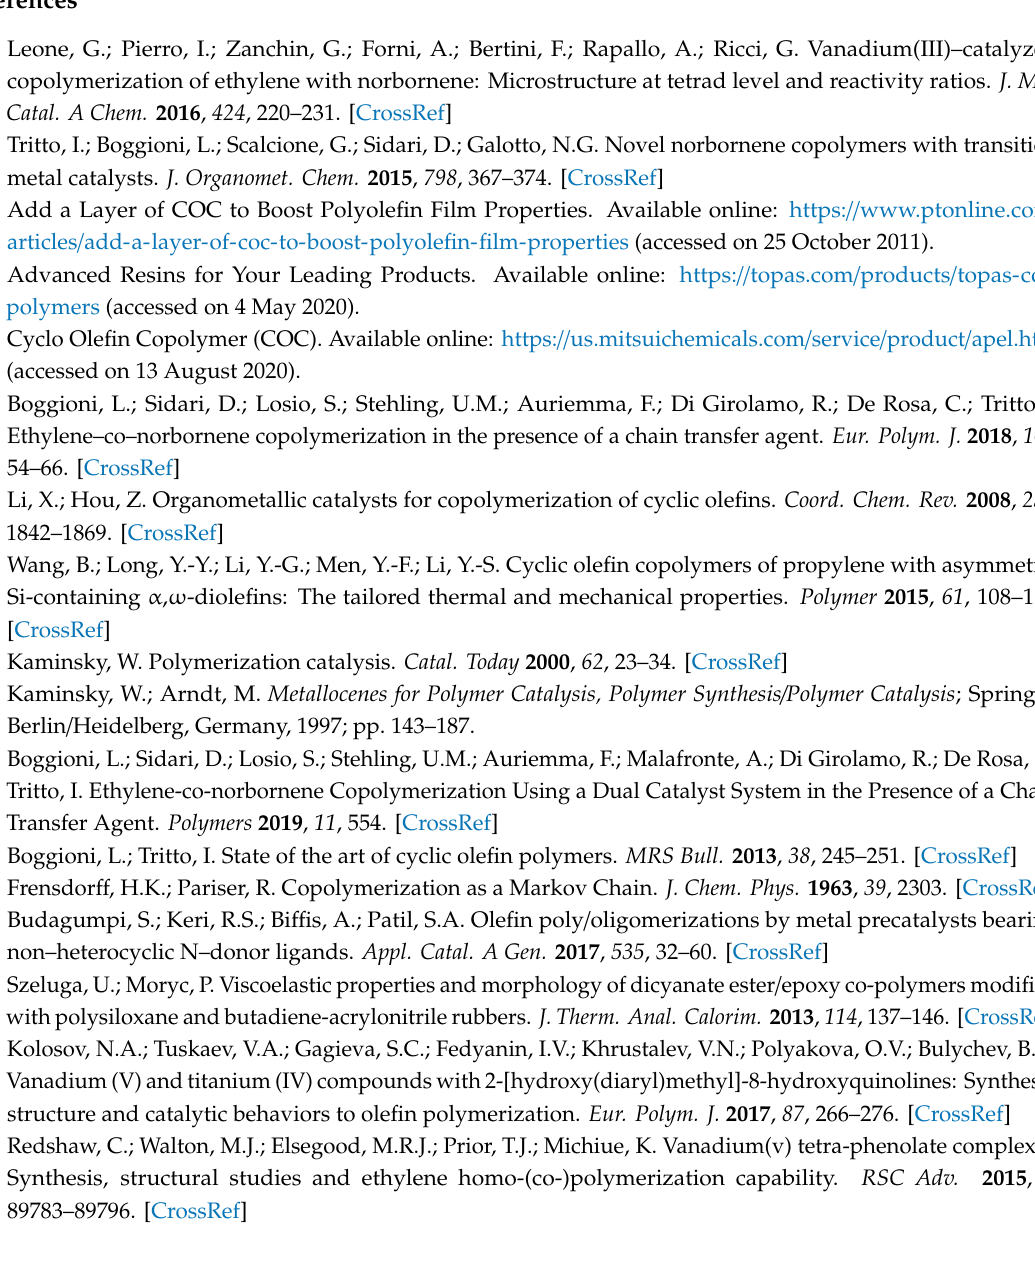
Figure S27: The 13 C NMR spectrum of E-NB copolymer with (34) C NB = 35.3 mol% obtained by SIL / C6 complex (item according to Table 1), Figure S28: The endothermic curves of E-NB copolymers obtained by C1 complex (items according to Table 1), Figure S29: The endothermic curves of E-NB copolymers obtained by C2 complex (items according to Table 1), Figure S30: The endothermic curves of E-NB copolymers obtained by C3 complex (items according to Table 1), Figure S31: The endothermic curves of E-NB copolymers obtained by C5 complex (items according to Table 1), Figure S32: The endothermic curves of E-NB copolymers obtained by SIL / C5 complex (items according to Table 1). Table S1. Structural parameters characterizing the ethylene / norbornene